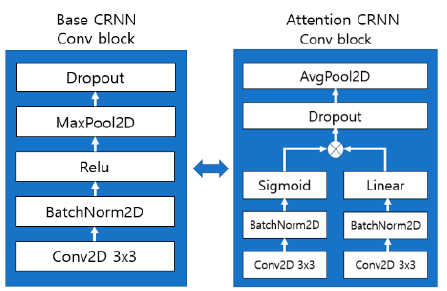
Figure 4. Structure of the gated linear unit (GLU) in the attention CRNN in comparison with the ConvBlock of the basic CRNN.